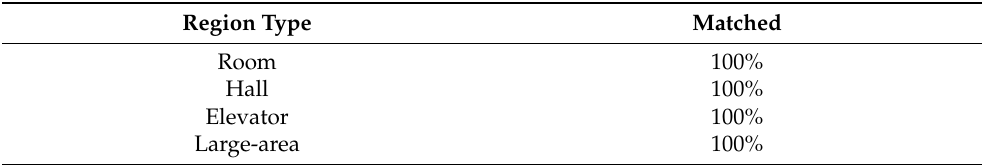
Table 3. Physical area recognition results.